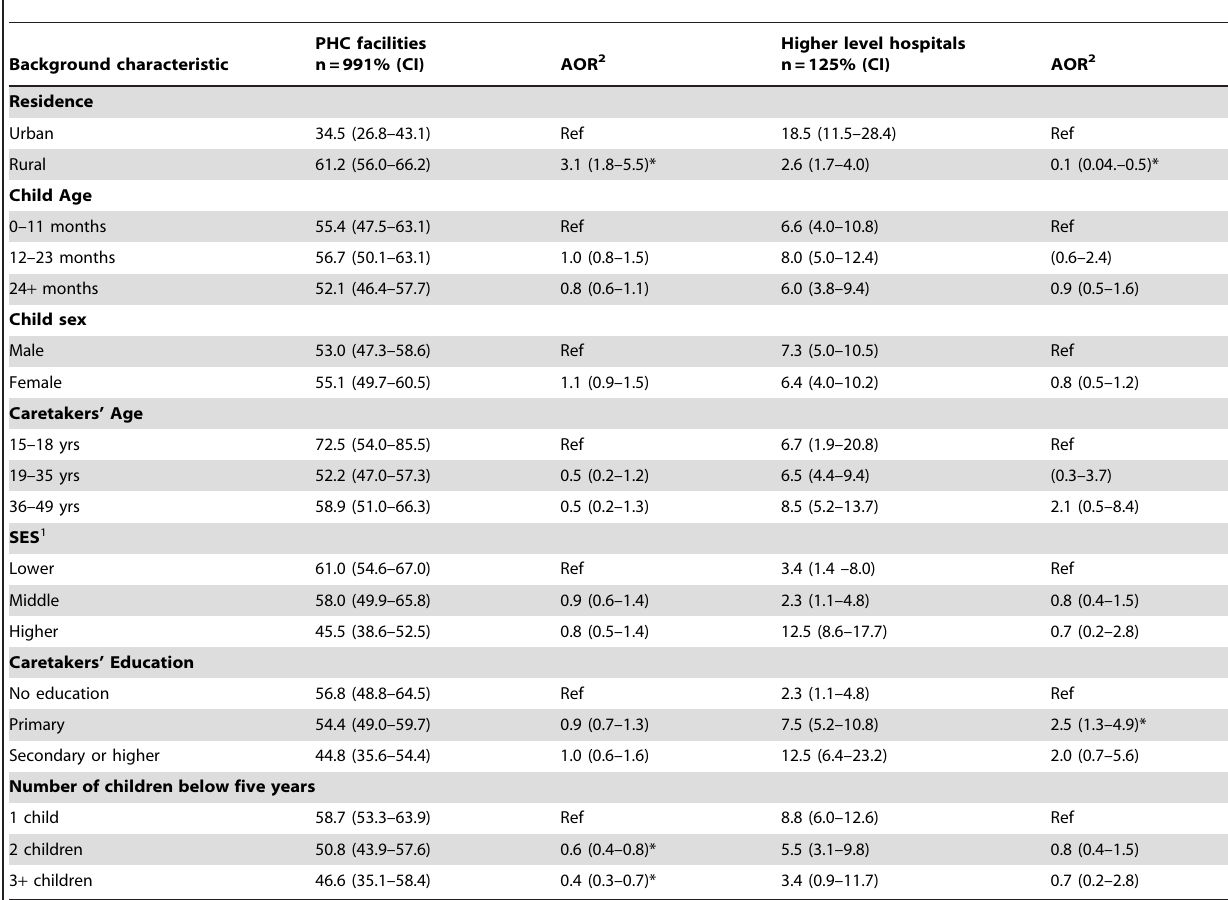
Table 4. Public facilities as the first option of care for fever and/or cough versus background characteristics.